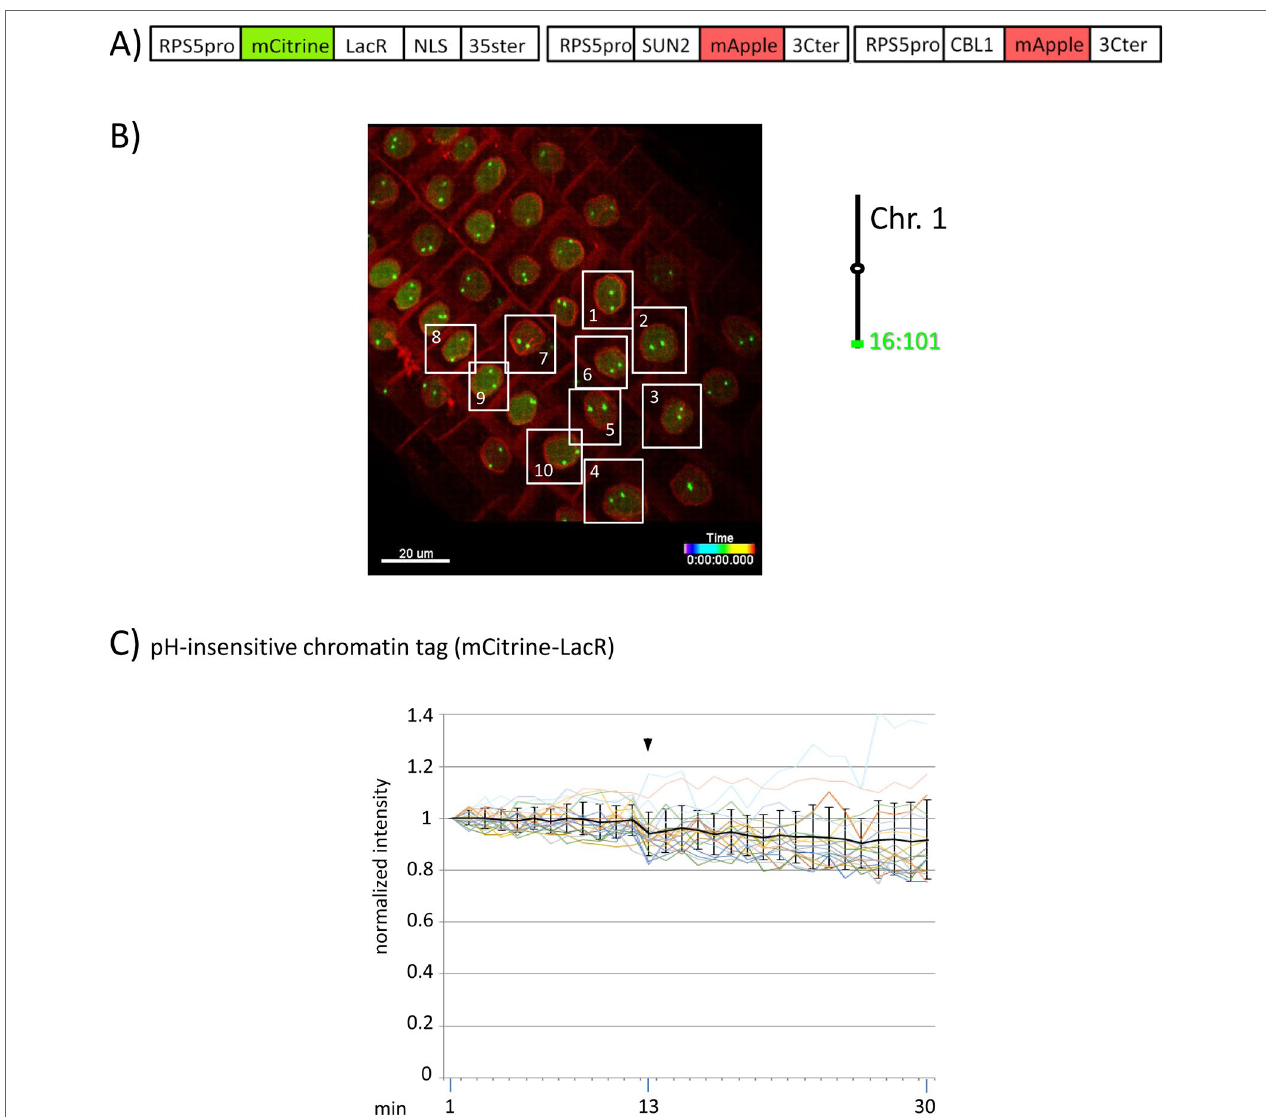
FIGURE 4 | Fluorescence intensity of a pH-insensitive fluorescent DNA-binding protein (mCitrine-LacR) following addition of eATP. (A) The construct encoded nuclear-localized mCitrine-LacR fusion protein as a pH-insensitive fluorescent DNA-binding protein, and SUN2-mApple and CBL1-mApple as IN﻿ and P﻿ visual markers. All three genes are under the transcriptional control of the RPS5 promoter; the first contains the 35ter and the last two contain the 3C terminator (3Cter). For readability, the module encoding RPS5pro-mCitrine-LacR is in the orientation shown but it is actually in the opposite orientation ( Data Sheet 1 , combination Figure 3 , in supplement). ( Data Sheet 1 , combination Figure 4 , in supplement). (B) Confocal image (maximum projection; enlargement in Data Sheet 9 in supplement) at time point t1 of homozygous fluorescent-tagged locus 16:101 in nuclei of cells in the root transition zone. Two green dots are visible in most nuclei. Nuclei used for fluorescence intensity analysis (part C ) are boxed in white. Right: The mCitrine-LacR fusion protein binds to lacO repeats integrated at locus 16:101 on the bottom arm of chromosome 1. (C) pH-insensitive chromatin tag (mCitrine-LacR): Fluorescence intensity profiles of normalized intensities of all 10 white-boxed nuclei (in part B ) are overlaid in one graph together with the calculated average values, to which standard deviation bars were added. Fluorescence intensities of individual nuclei can be viewed in supplementary Data Sheet 8 , part Figure 4C . Addition of eATP is indicated with black arrowheads at frames 13-14. Normalized and non- normalized numbers are shown, respectively, in sheets 5 of Tables 10 and 1 , in supplement. Using the normalized data, the calculated difference in the magnitude of the drop in fluorescence intensity of SEpHluorinD-LacR ( Figure 3D ) versus bleaching of mCitrine-LacR (this figure) between the time points 14-16 points in response to eATP is statistically significant ( p ≤ 0.05). Fluorescence intensity at genomic location is read in spot objects (1-2.8 μm) capturing punctual